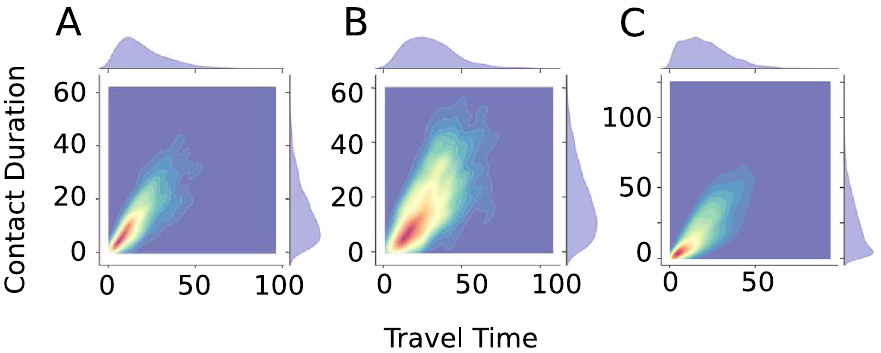
Figure 6. The correlations between travel time and total contagion duration in MCNs of three cities. 50 MCNs are generated for each plot using data from 8:00 to 8:30 AM, with each MCN having 1000 nodes. ( A )–( C ) represent results for Guangzhou, Shanghai, and Shenzhen,